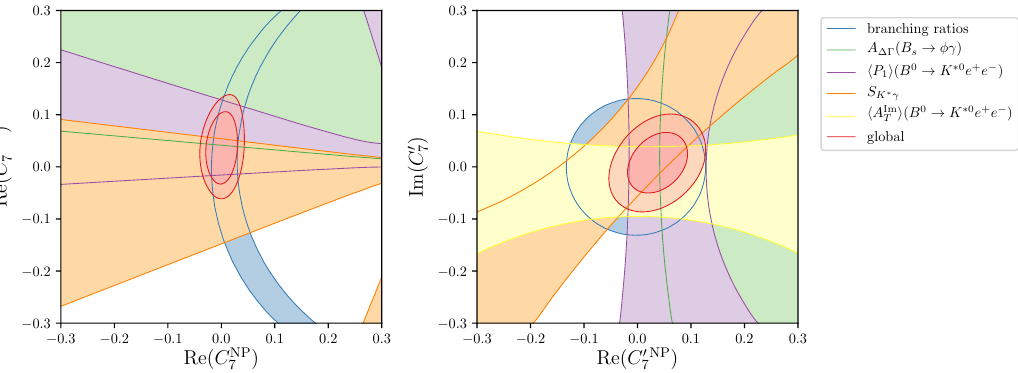
Figure 3 . Constraints on NP contributions to the Wilson coe(cid:14)cients C constraints, 1 and 2 (cid:27) contours are shown, while the individual constraints are shown at 1 (cid:27) level. Our main (cid:12)ndings can be summarized as